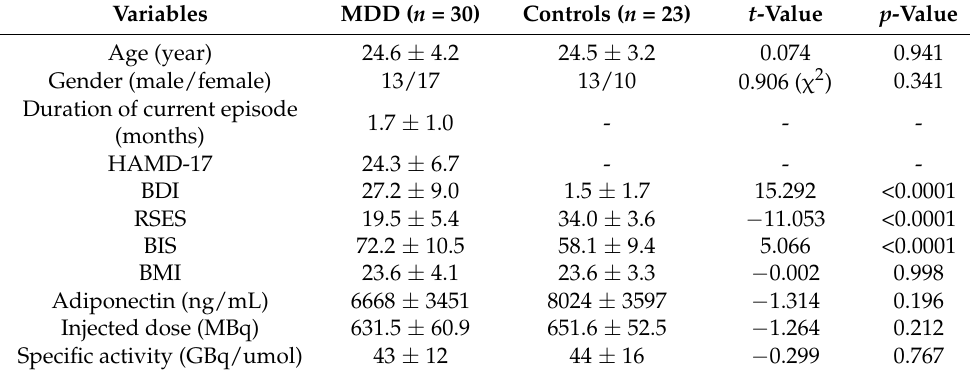
Table 1. Demographic/clinical characteristics and PET scan